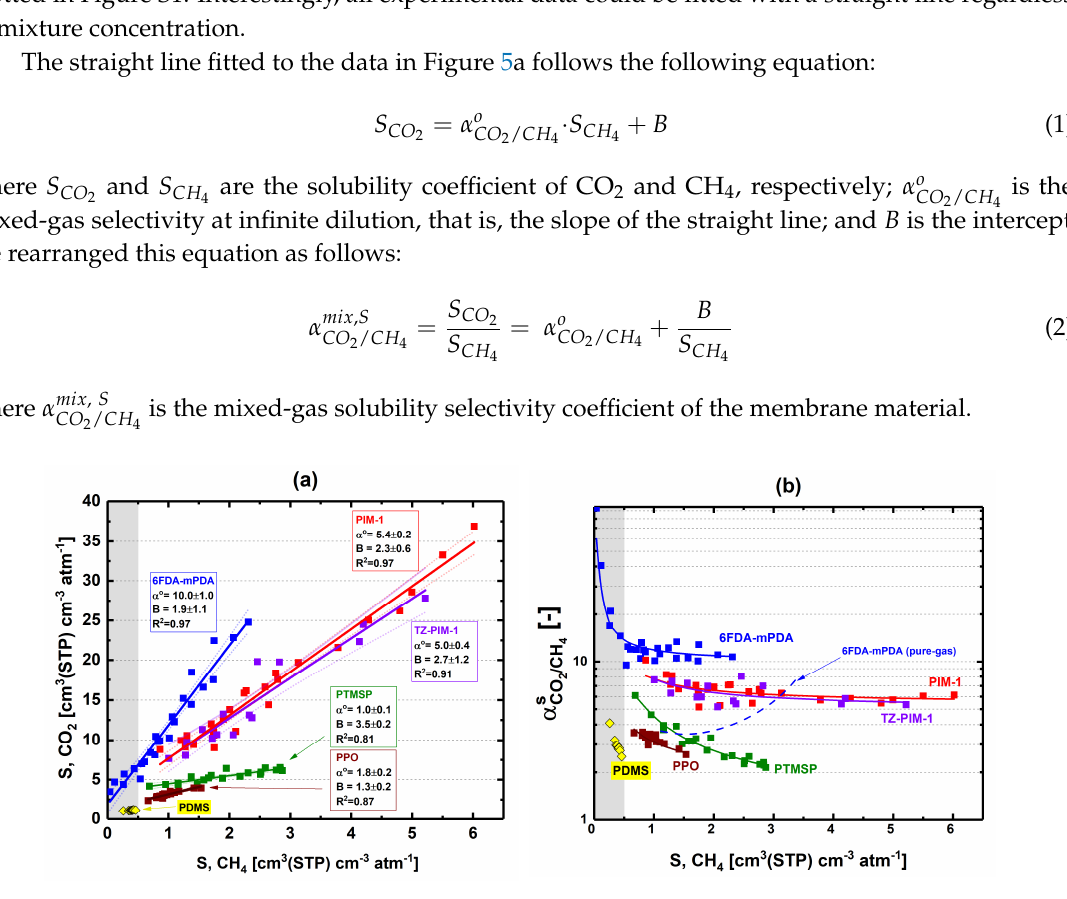
Figure 5. ( a ) CO 2 vs. CH 4 mixed-gas solubility coefficient of 6FDA-mPDA at 35 ◦ C—solid lines were estimated via linear fitting of experimental data (the dotted curves delimit the confidence intervals of each linear interpolation); ( b ) data of CO 2 /CH 4 mixed-gas solubility selectivity vs. CH 4 mixed-gas solubility coefficient of 6FDA-mPDA (CO 2 /CH 4 mixed-gas solubility selectivity vs. CH 4 mixed-gas solubility coefficient mixed- (solid line) and pure-gas trends (dashed-line) are also shown for comparison). Mixed-gas solubility coefficient data from previous reports on PDMS [11], PIM-1 [20], TZ-PIM-1 [23], PTMSP [15], and PPO [18] are included in ( a , b